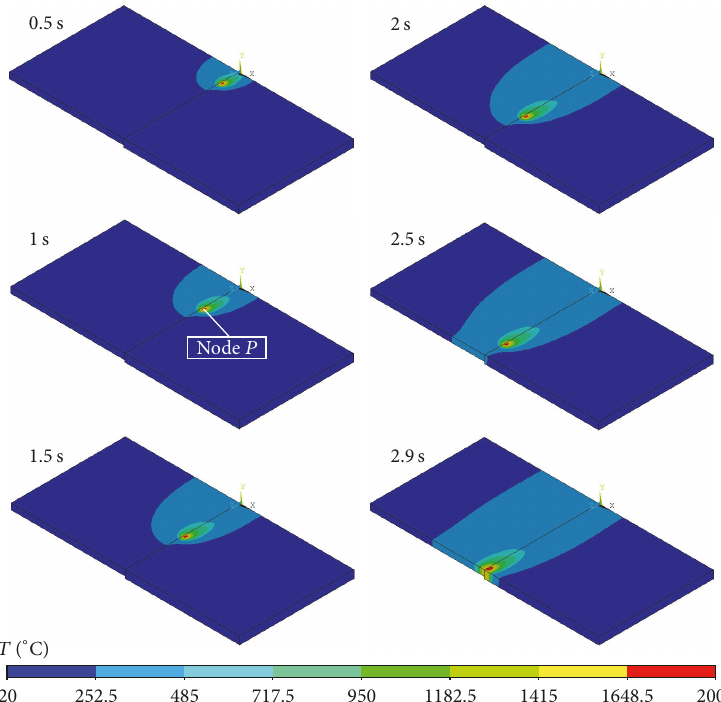
Figure 7: Temperature distribution in welded sheets in chosen times for sample 3 (the laser power of 850 W and the laser offset of 250 𝜇 m).